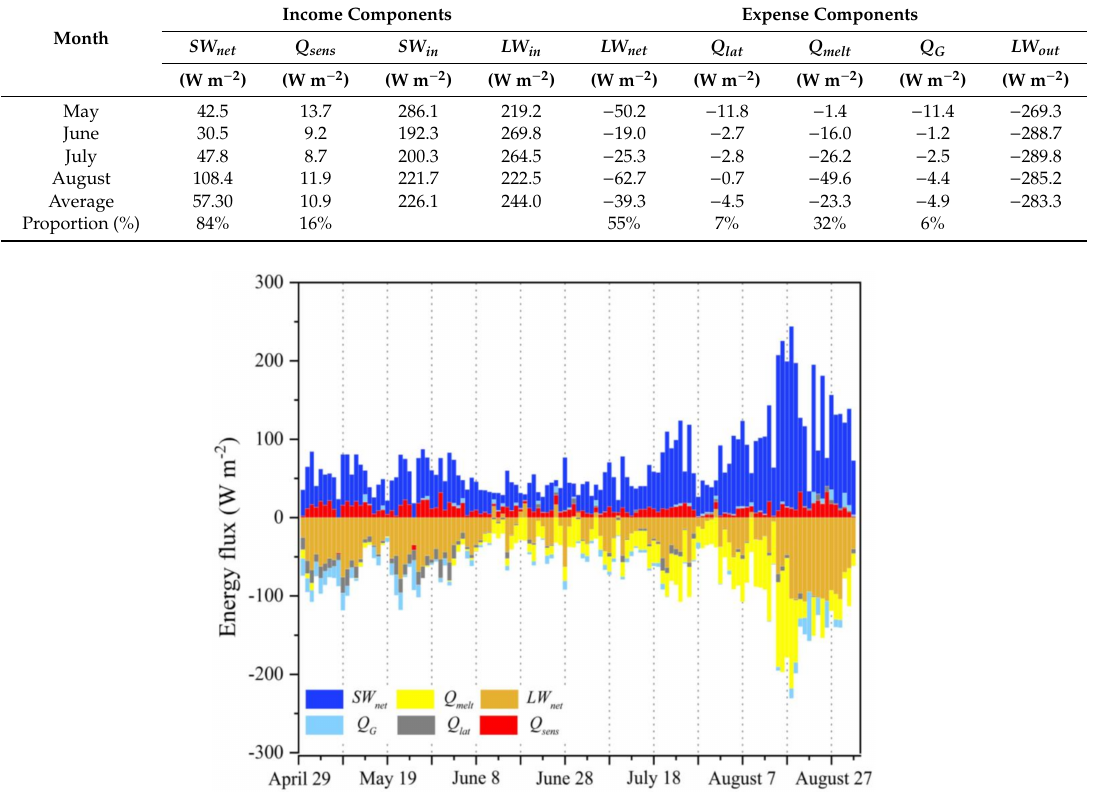
Figure 3. Daily energy flux components at the site of AWS1 on the east branch of UG1 during the ablation period of